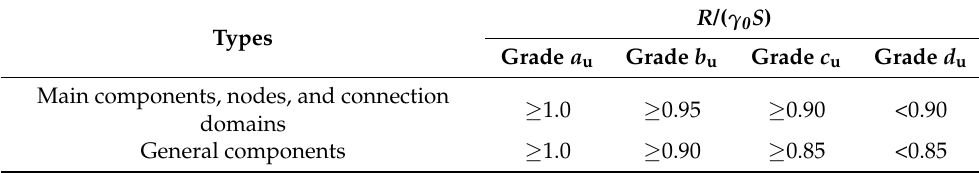
Table 6. Evaluation of load-carrying capacity grades of steel structural members.